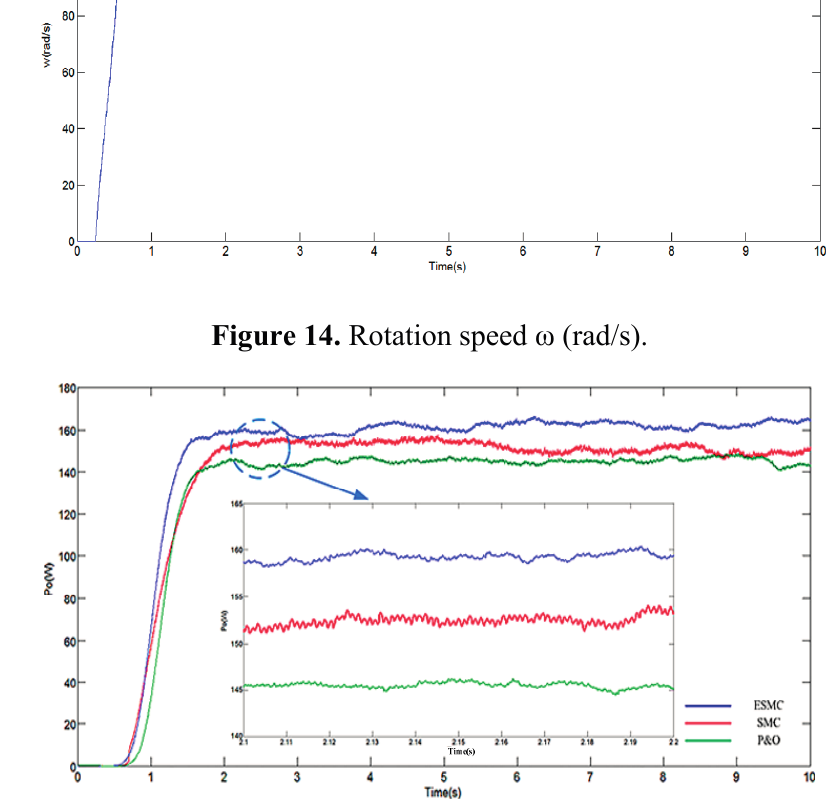
Figure 15. Experimental output power of the three control modes.